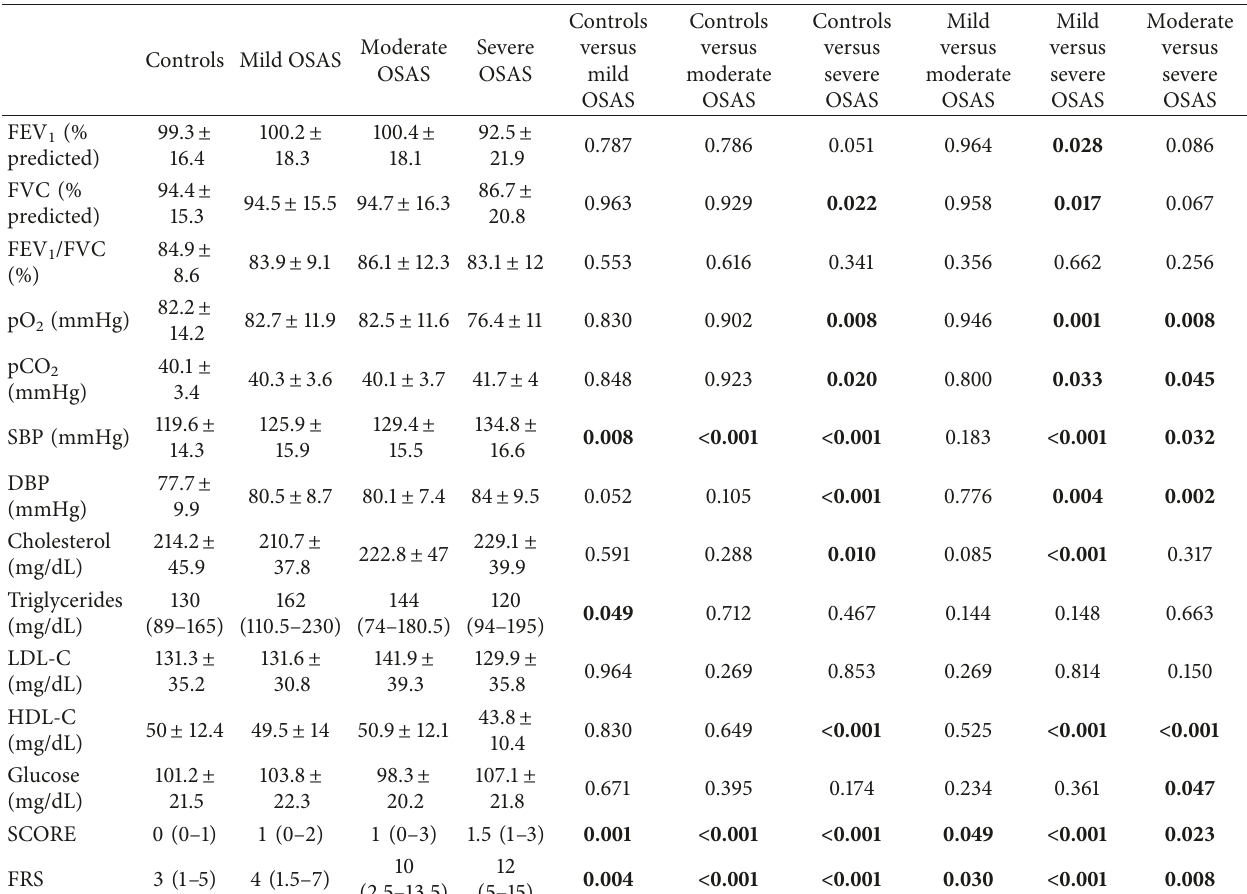
Table 3: Comparison of the laboratory measurements between controls and obstructive sleep apnea syndrome (OSAS) patients. Moderate Severe Controls Mild OSAS OSAS OSAS